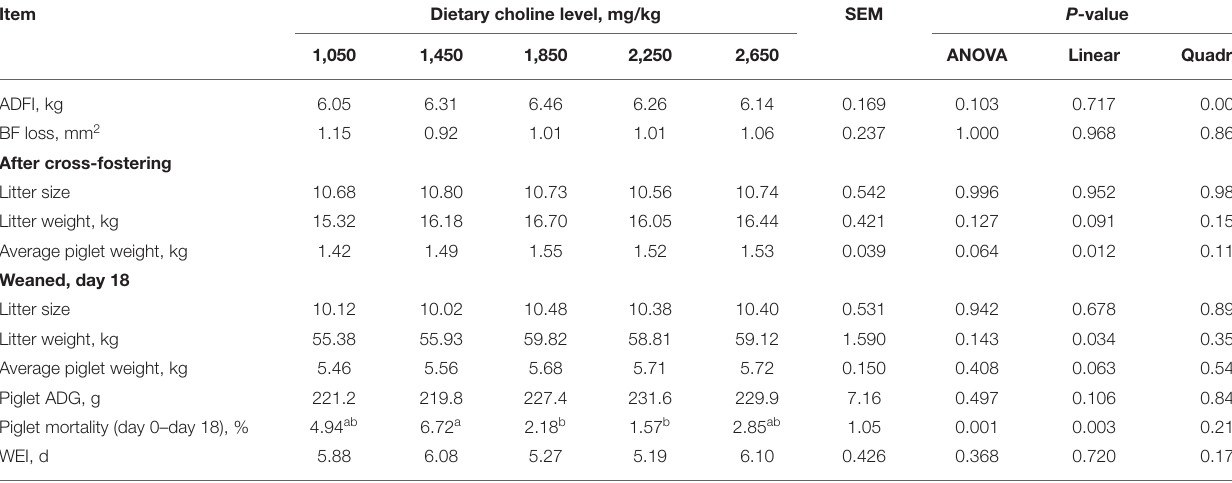
TABLE 3 | Effect of dietary choline levels during gestation on lactation performance of sows 1 . Item Dietary choline level, mg/kg P -value